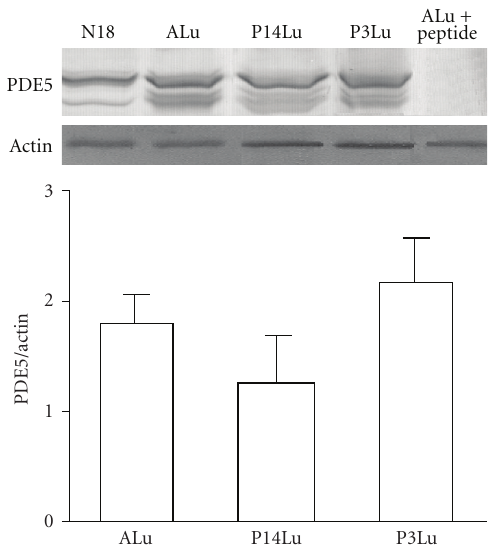
Figure 1: PDE5 expression at di ff erent stages of rat lung develop- ment. Upper panel: representative western blot analysis of adult lung (ALu), 14 day-old lung (P14Lu), 3 day-old lung (P3Lu), adult lung incubated in presence of PDE5-peptide (ALu+peptide). N18 cell culture (N18) was utilised as standard of PDE5. Each lane was loaded with 50 μ g of protein. Lower panel: densitometric quantification of immunoreactive PDE5 and actin bands. Data are mean ± SD of 3 di ff erent experiments. Di ff erences were not significant (ANOVA